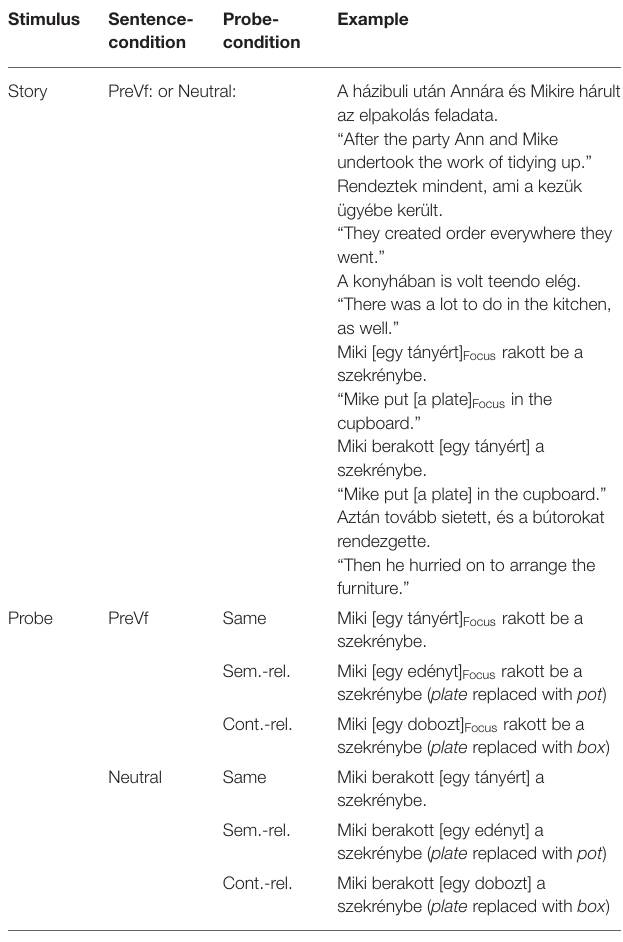
TABLE 1 | Conditions and examples. Stimulus Sentence-